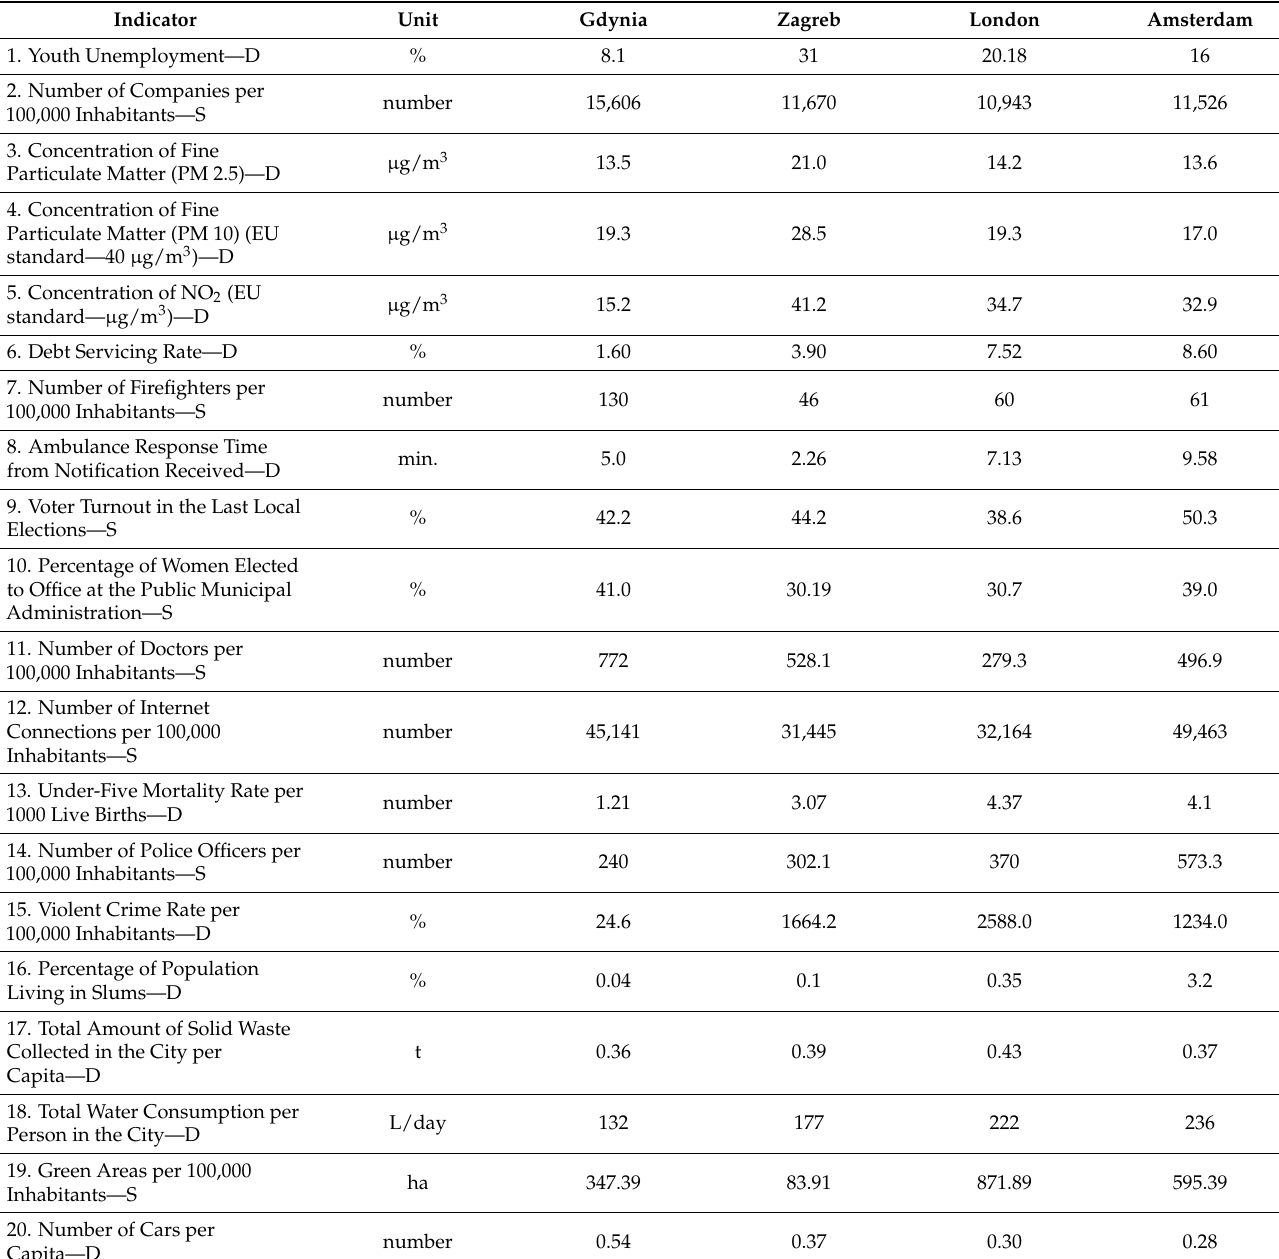
Table 1. Indicators as per the ISO 37120 standard applied in the analysis with regard to the selected European cities. Indicator Unit Gdynia Zagreb London